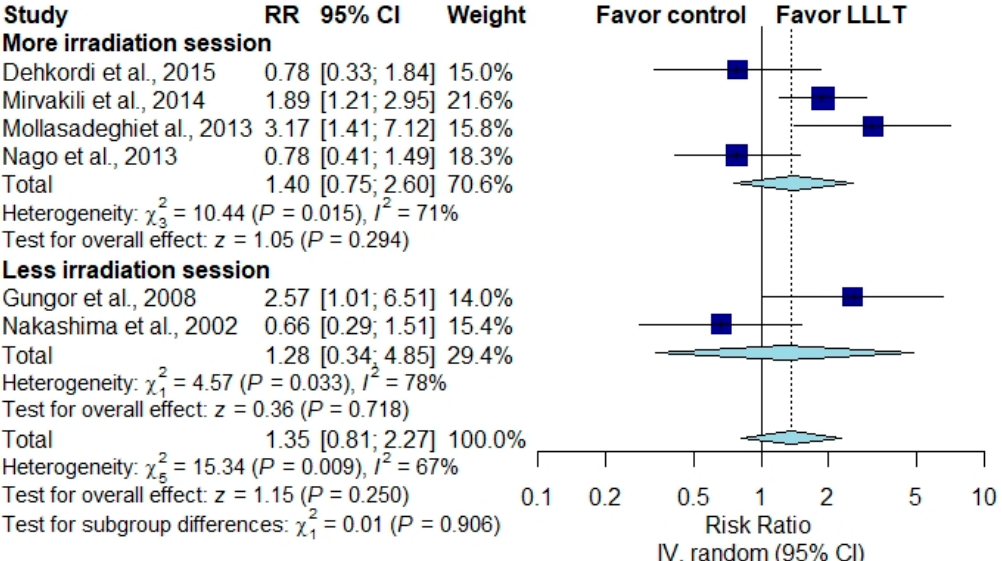
Figure 7. Subgroup analysis of rating scale score improvement rates according to the number of